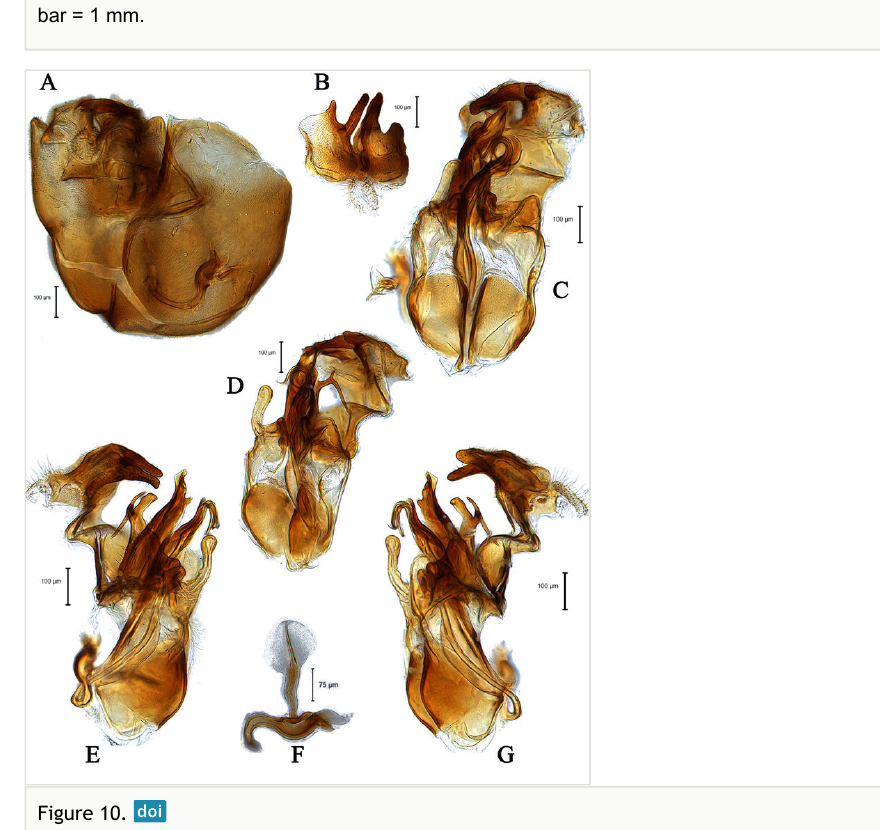
Figure 9. Male of Eudorylas corniculans Motamedinia & Skevington sp. n. (JSS52187; most of abdomen removed for terminalia dissection) (A) habitus in dorsal view; (B) habitus in lateral view. Scale bar = 1 mm.